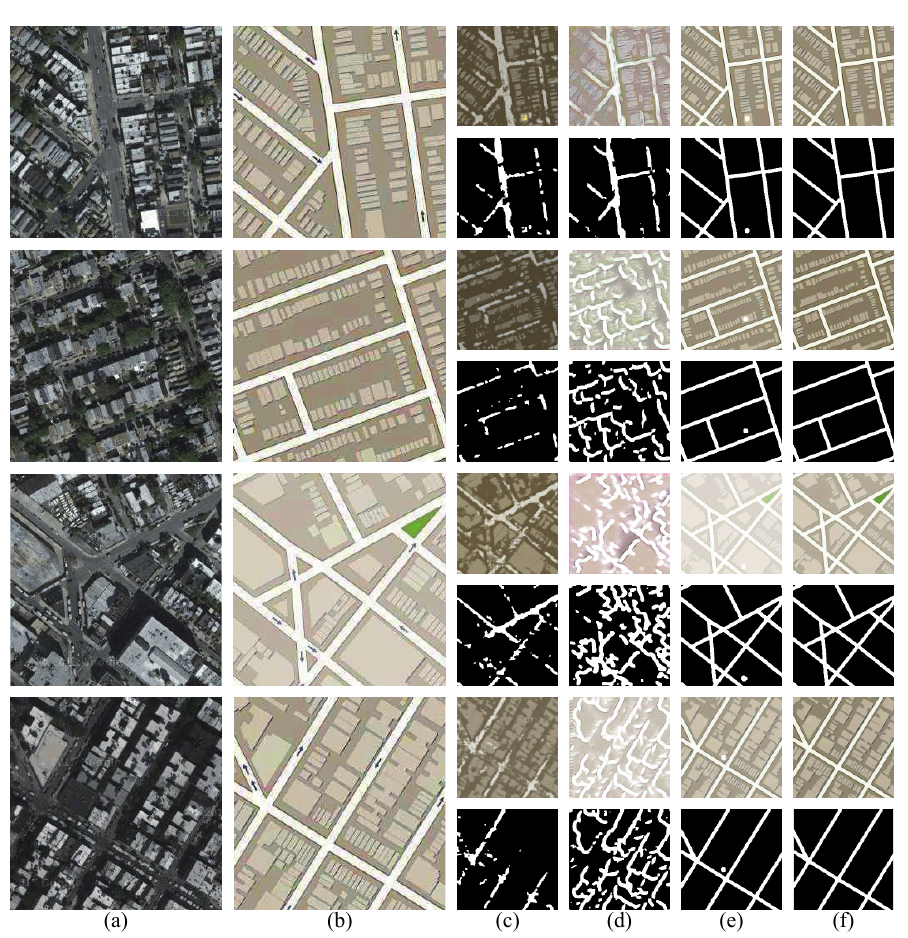
Figure 11. Results of the four mapping networks: ( a ) remote sensing image, ( b ) mapping image, ( c ) the standard GAN with the Res-net framework’s generated mapping and binary images, ( d ) the standard GAN’s generated mapping and binary images, ( e ) the WGAN with the Res-net network’s generated mapping and binary images, and ( f ) the WGAN-GP with the Res-net network’s generated mapping and binary images (WSGAN).